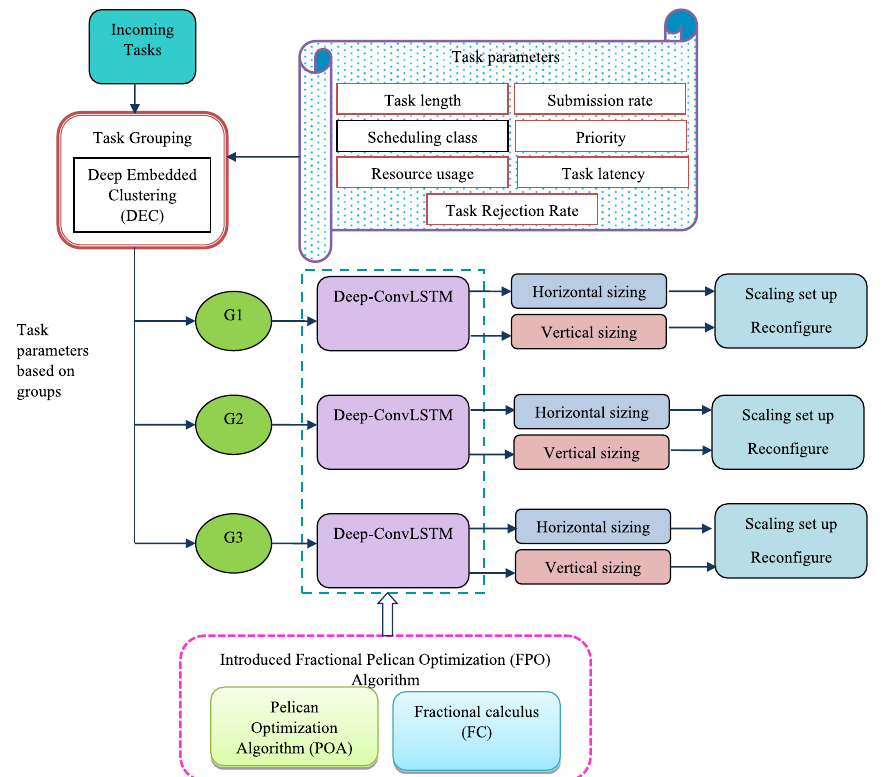
Fig. 3 Schematic representation of the developed VM sizing technique based on Task grouping and optimized deep learning for hosting